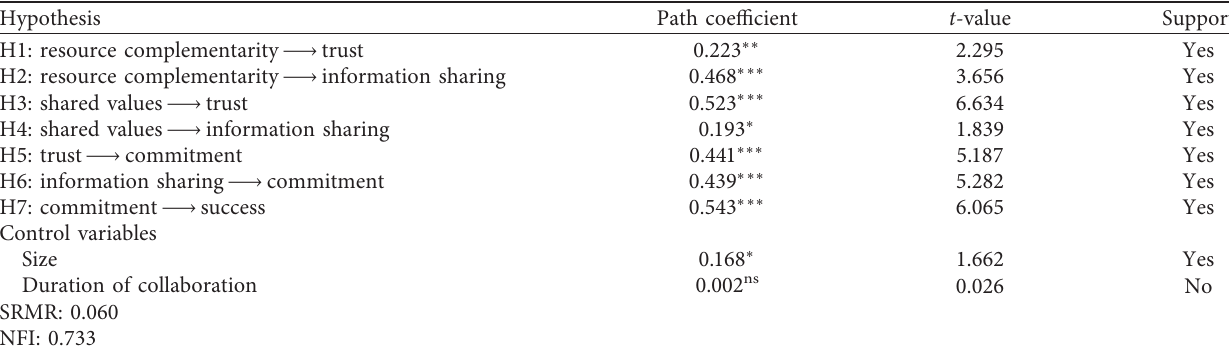
Table 12: Structural model